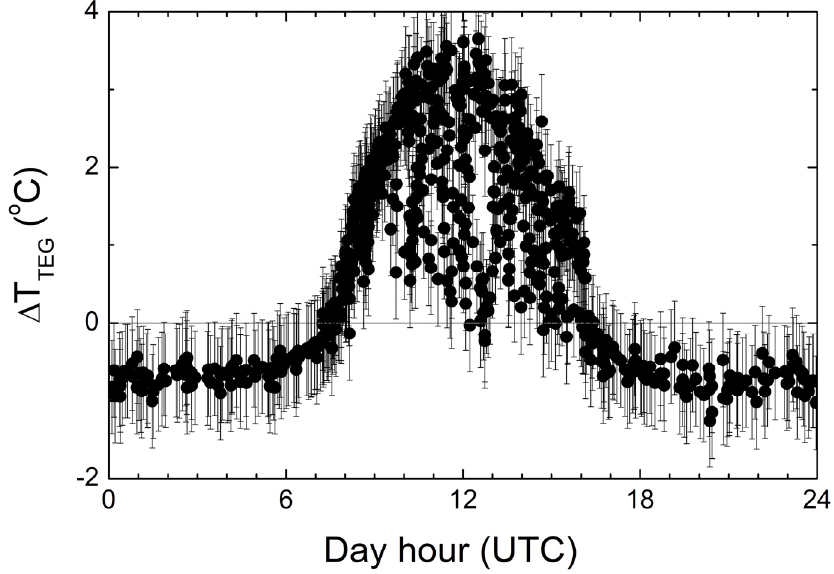
Figure 9. Hourly TEG temperature differences from collected data (Figure 8). Data available in the Supplementary Materials.